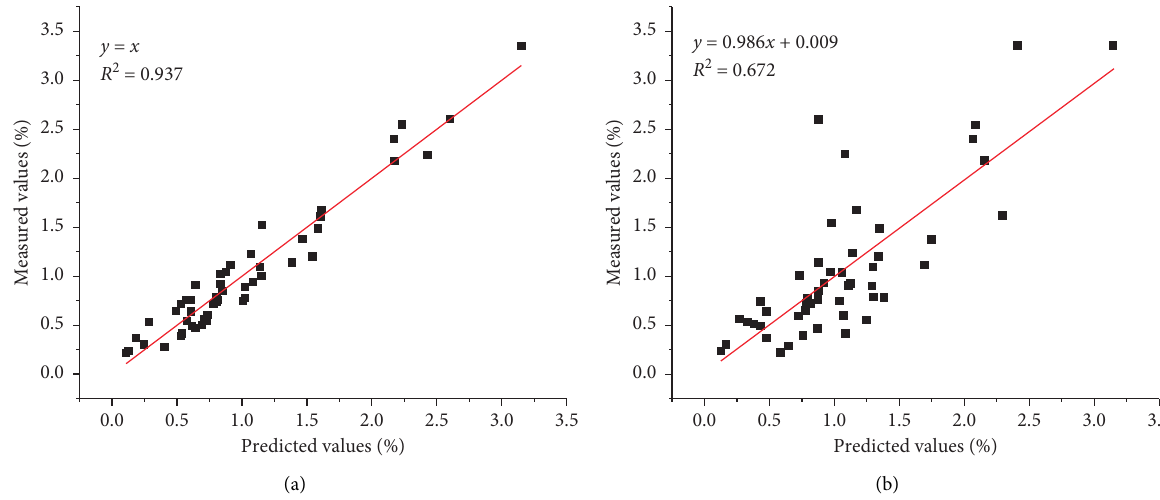
Figure 2: Relation between the measured values and the predicted values for the grain resistance starch content by the calibration models obtained by ATR-MIR and NIR. (a) The calibration model obtained by ATR-MIR. (b) The calibration model obtained by